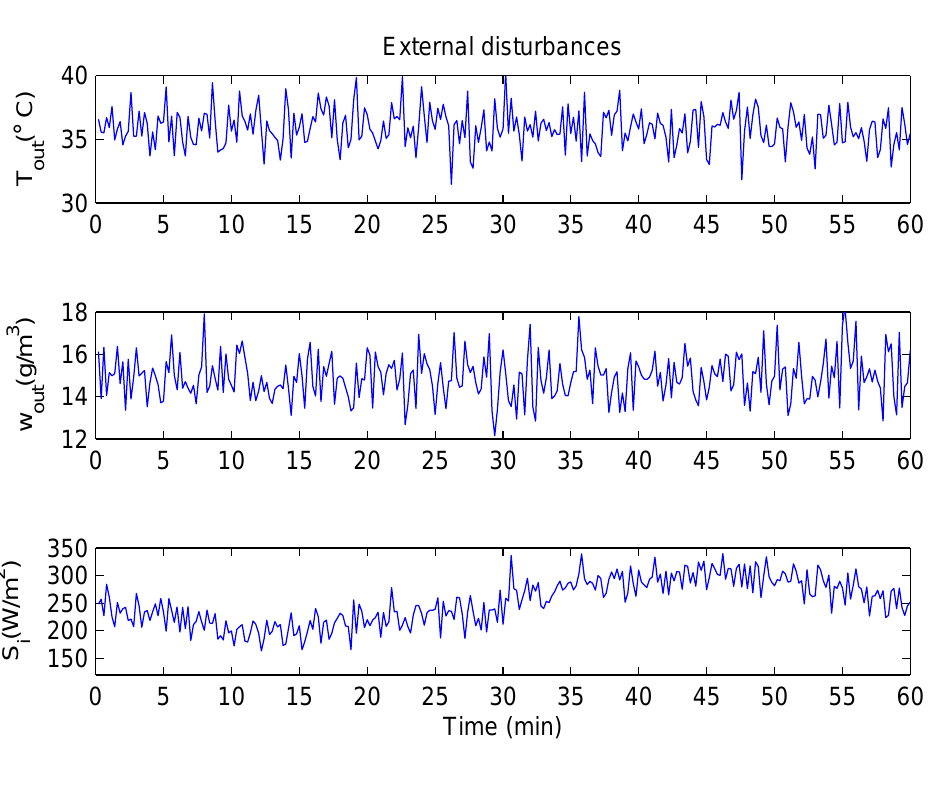
Figure 3. Changes of outdoor air temperature, humidity ratio and solar